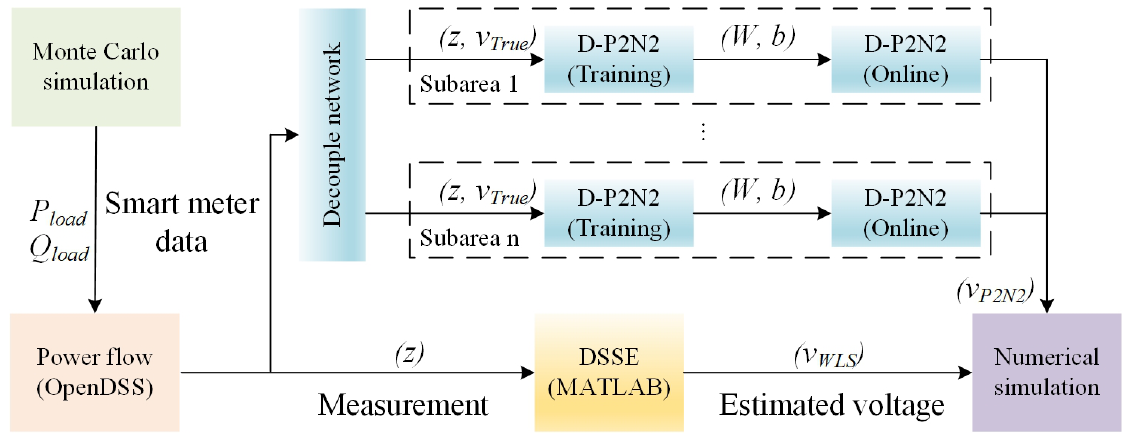
Figure 1. The methodology of the proposed